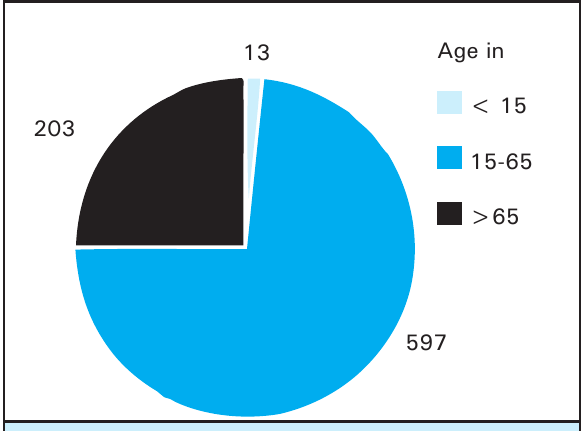
Figure 1. Age distribution of patients (percentage).